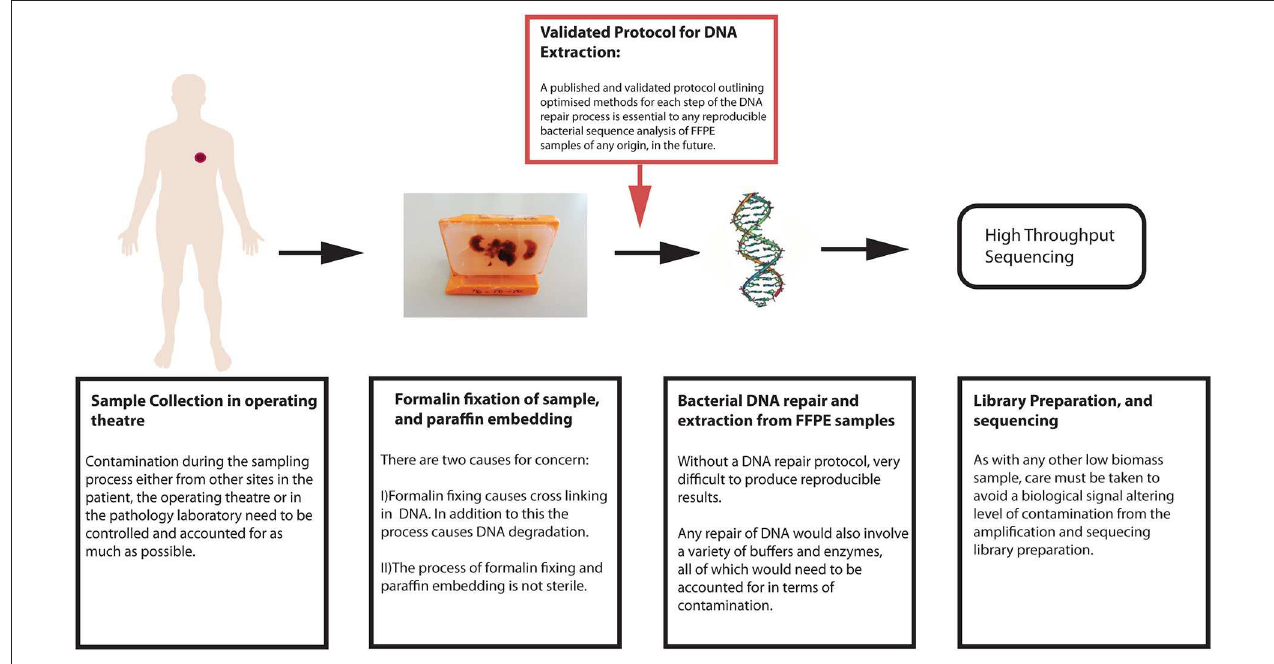
FIGURE 3 | Workflow of biological considerations prior to bioinformatic sequence analysis.